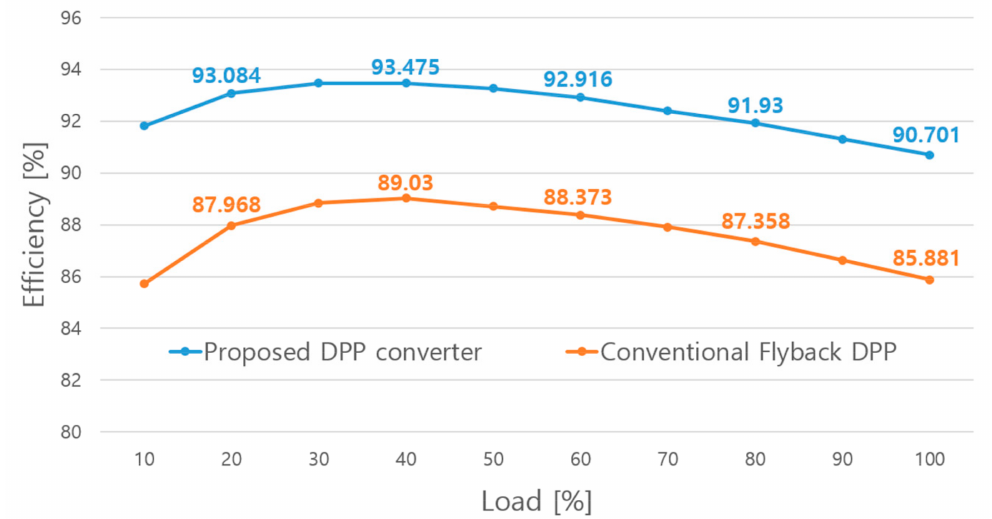
Figure 17. Variation of measured efficiency with a load for 8 V input and 30 V